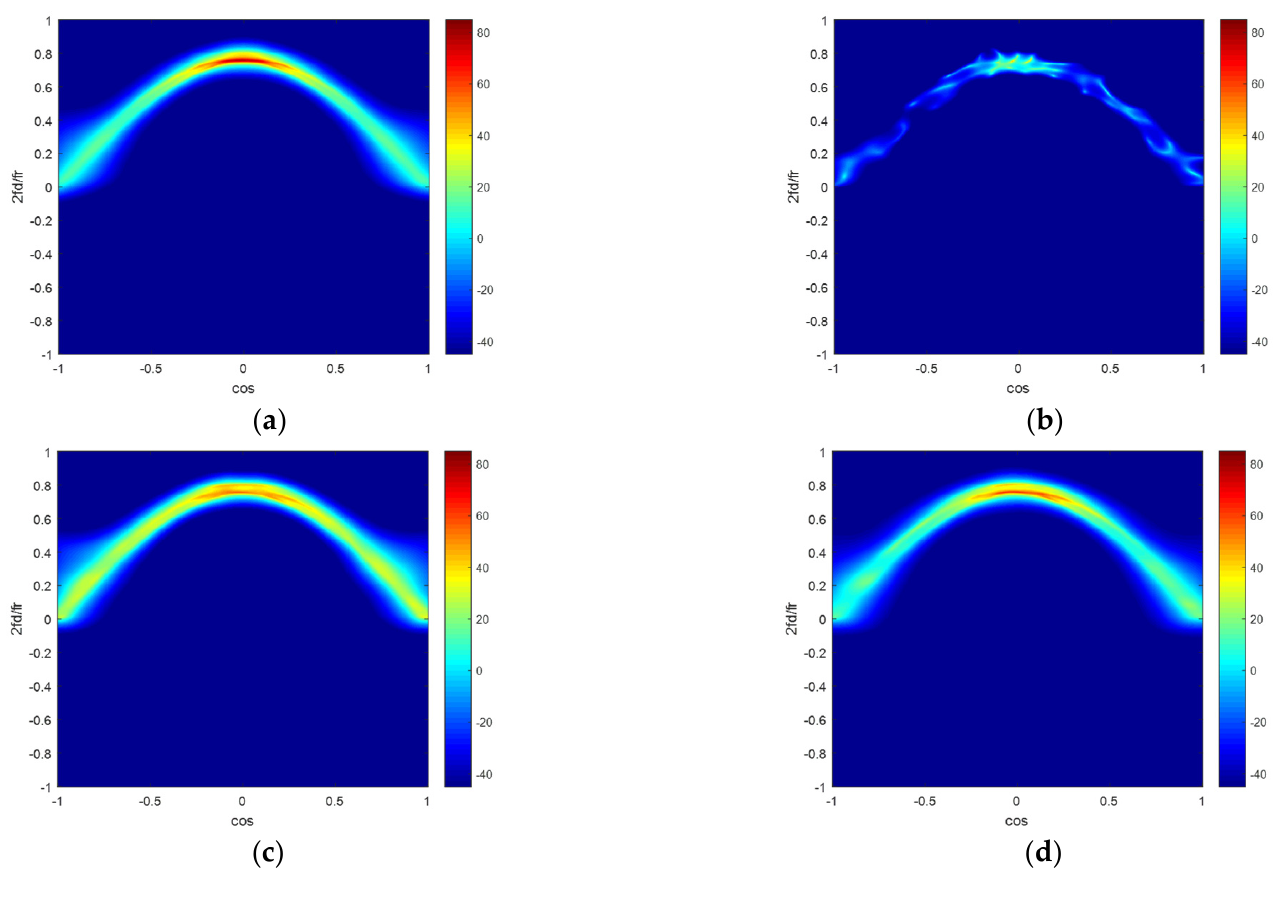
Figure 7. Clutter Angle-Doppler capon spectrums estimated by different methods in the non-ideal condition with ICM: ( a ) the ideal CNCM; ( b ) SMI; ( c ) KASPICE-STAP; ( d ) the proposed method. In the presence of ICM, the IF curves with different methods have been shown in Figure 8. The standard variance of the clutter spectrum spread is 0.22 m/s in Figure 8a and 0.56 m/s in Figure 8b. We can see that the proposed method still preserves desir- able